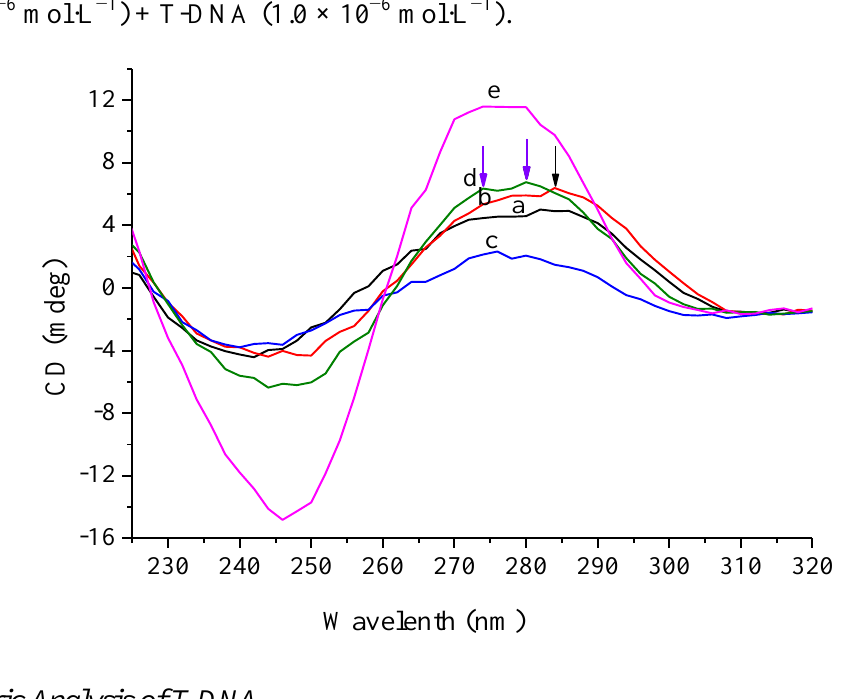
Figure 3. CD spectra of ( a ) probe-1 (1.0 × 10 −6 mol·L −1 ), ( b ) probe-2 (1.0 × 10 −6 mol·L −1 ), ( c ) probe-3 (1.0 × 10 −6 mol·L −1 ), ( d ) probe-4 (1.0 × 10 −6 mol·L −1 ), ( e )